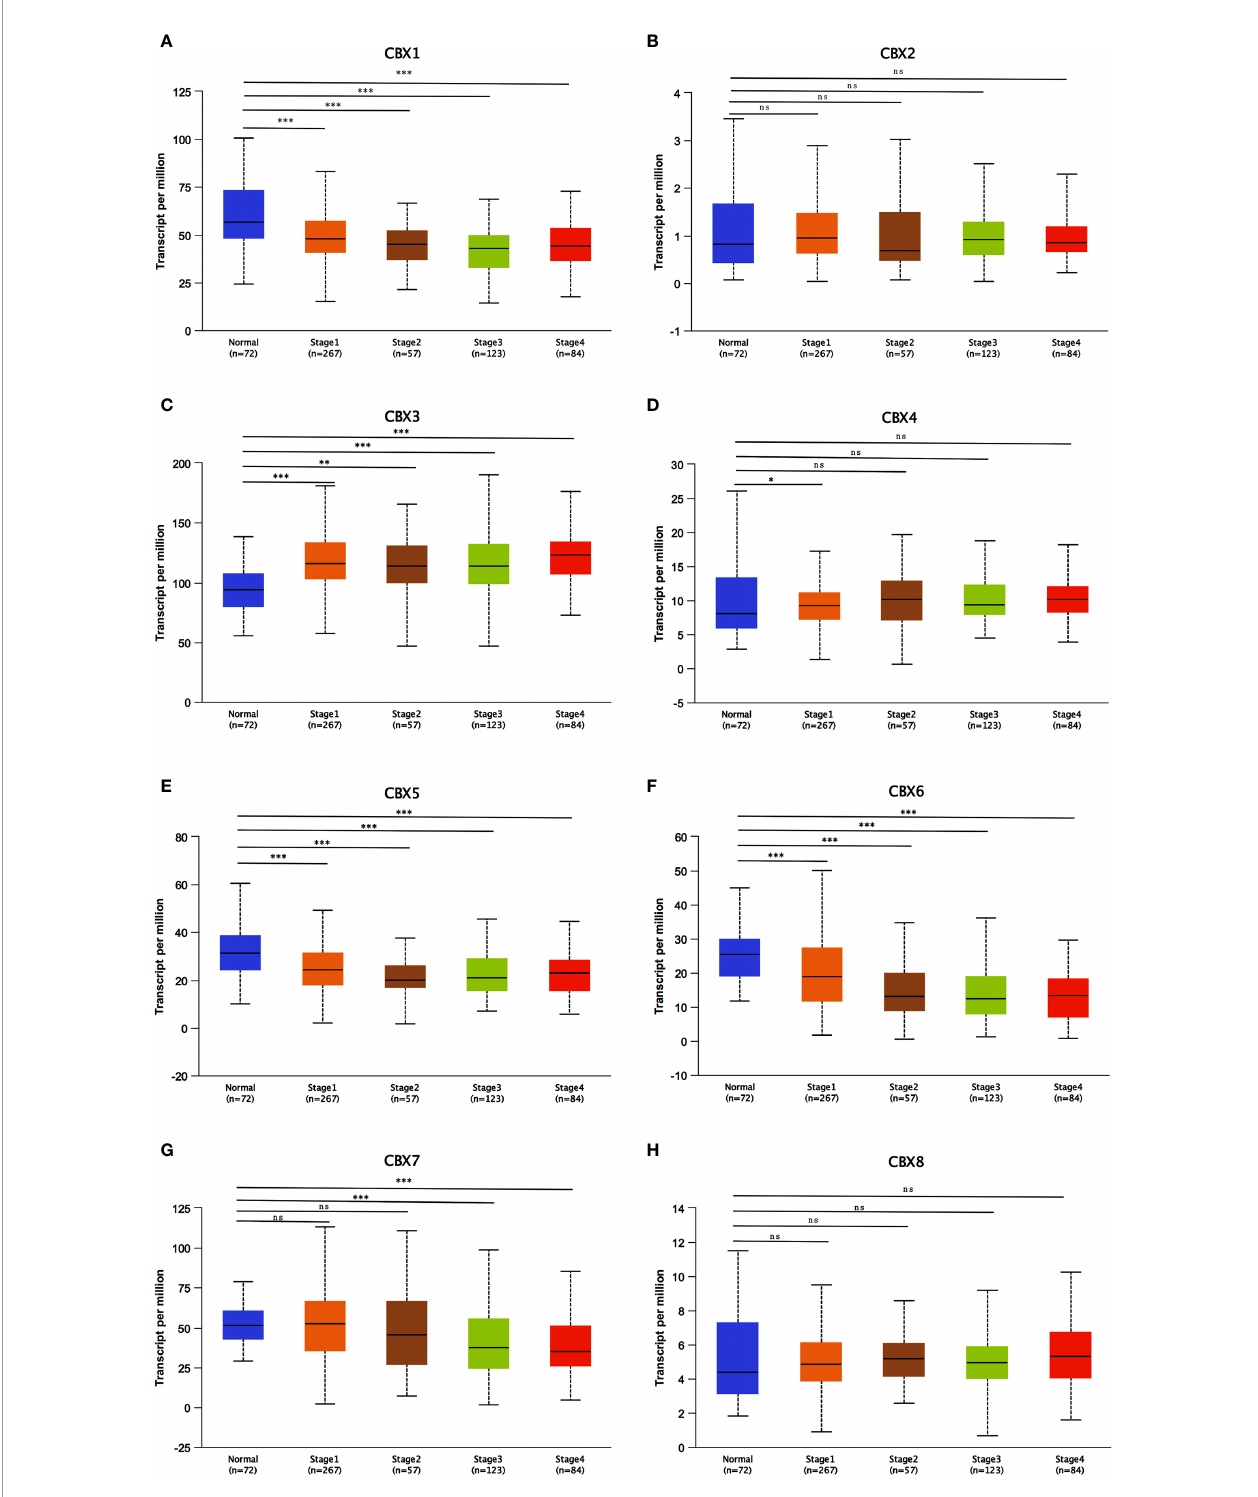
FIGURE 9 | Correlation between CBXs expression and tumor stages in ccRCC patients (UALCAN). Low expression of CBX1, CBX5, CBX6, CBX7 (A, E – G) , and high expression of CBX3, CBX4 (C, D) were signi fi cantly correlated with advanced cancer stages. CBX2 and CBX8 did not signi fi cantly differ in tumor stages (B, H) . (* P <0.05, ** P <0.01, *** P <0.001, ns, no signi fi